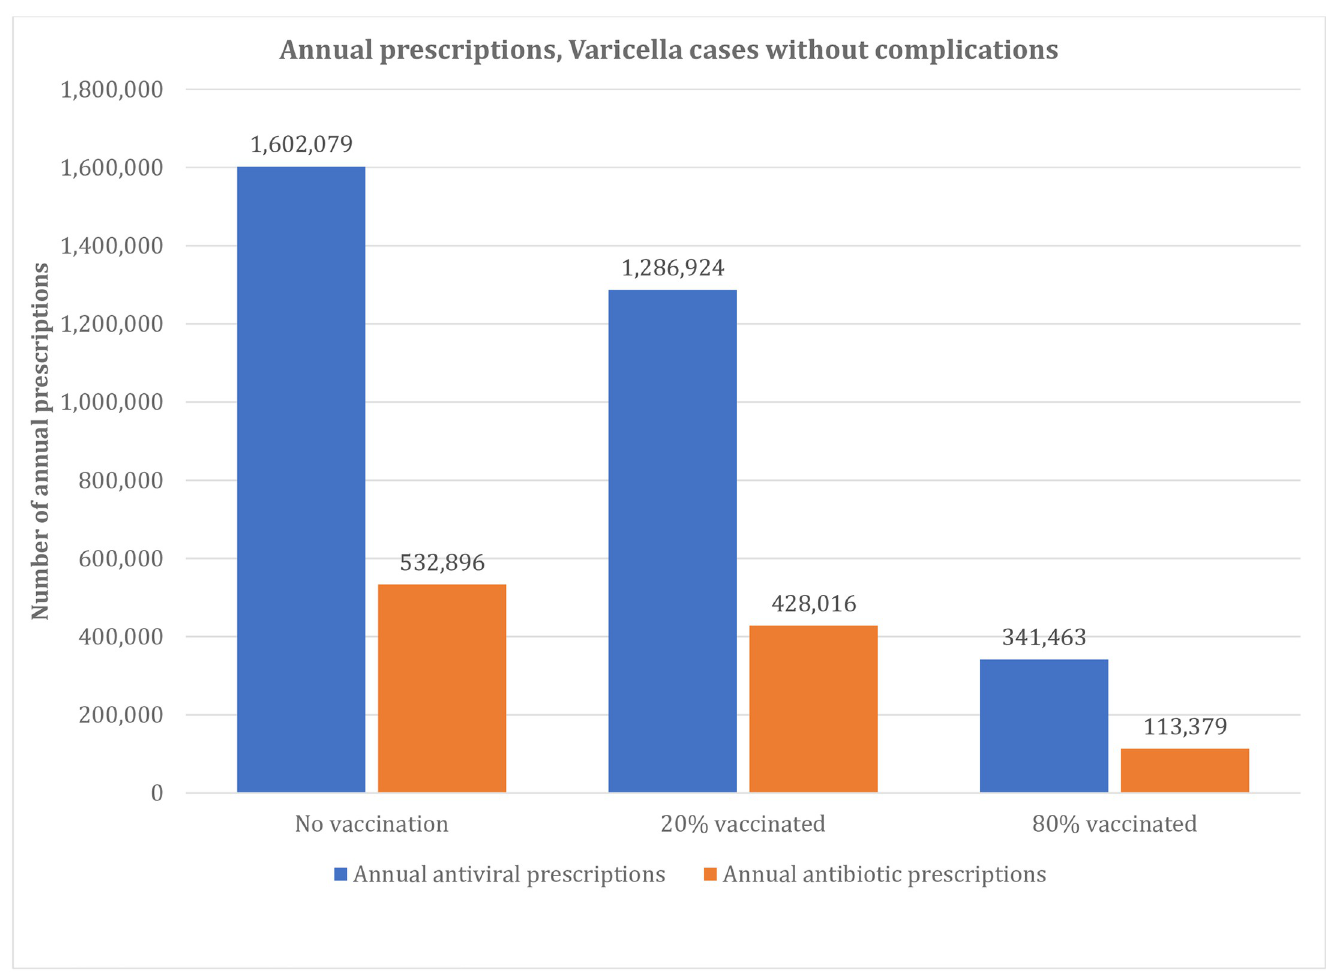
Fig 2. Estimated annual prescriptions (varicella cases with no complications), scenario analysis. � Total number of annual prescriptions. † Annual prescriptions avoided when compared to no vaccination scenario.